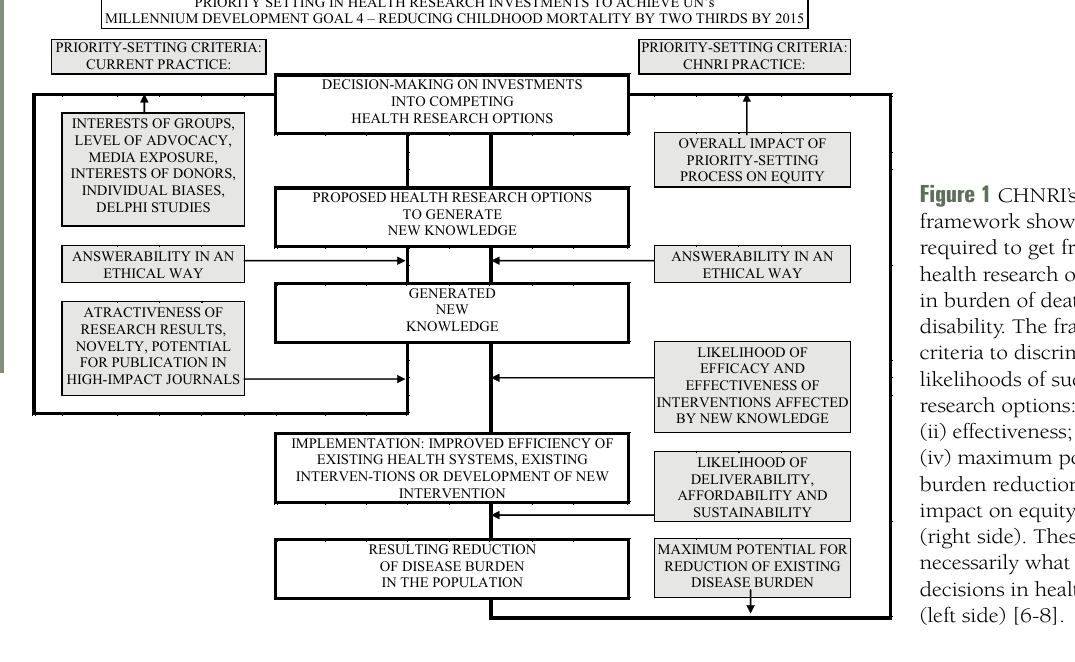
Figure 1 CHNRI’s conceptual